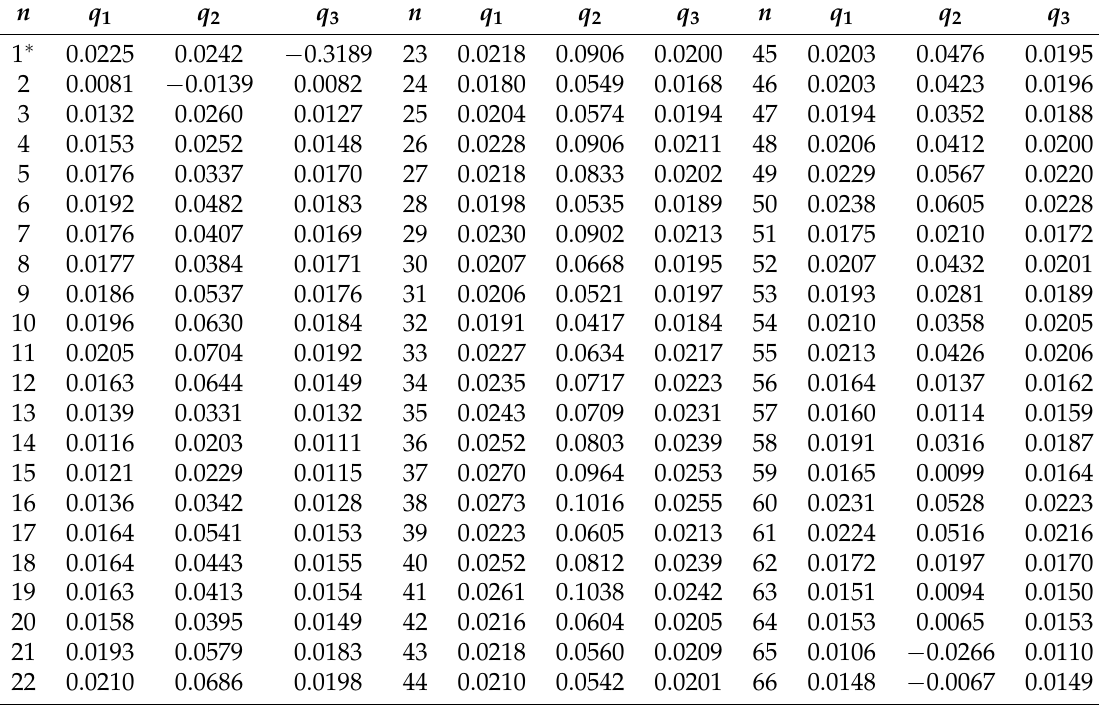
Table C3. The coefficients for the fitting function of P fix against P f , ILS . The tolerable failure rate